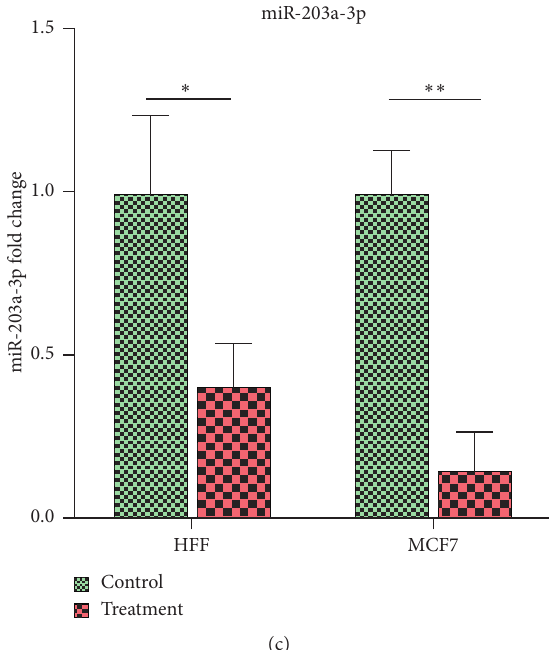
Figure 8: The Tukey multiple comparisons showed the x -level expression of miR-155-5p (a), miR-223-3p (b), and miR-203a-3p (c) between treatment and control groups in HFF and MCF7 cell lines. In these diagrams, the control group was used as the reference group for each cell line. Each cell line was analyzed separately, and only their diagrams were displayed side by side. In other words, it is not possible to compare different cell lines; for example, the HFF control group cannot be compared with the MCF7 control group. ∗ refers to the significance p < 0 . 05, and ∗∗ refers to p < 0 .